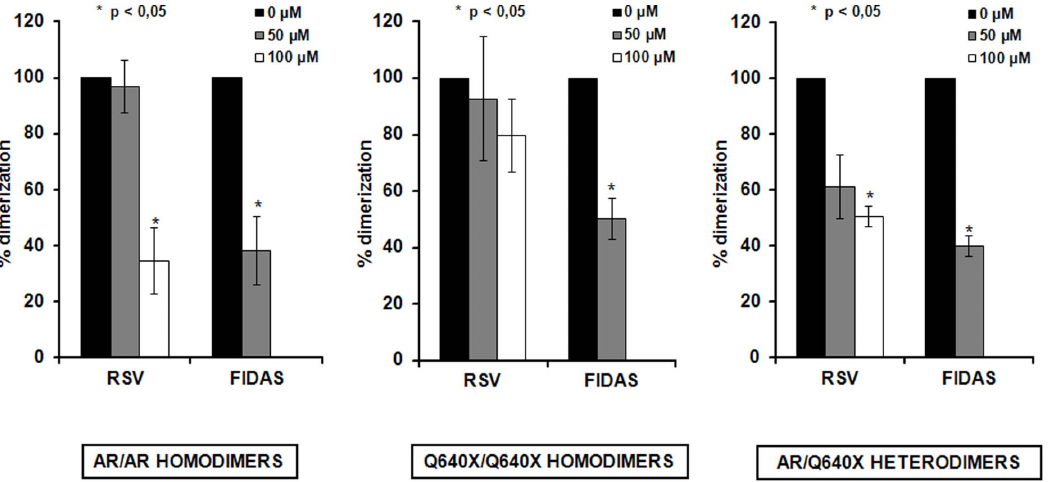
Figure 5. Effects of RSV and FIDAS on the dimerization of AR and Q640X. Formation of AR and Q640X homo/hetero-dimers was analyzed 24 hours after RSV or FIDAS treatment using a M2H as described in Material and Methods. Within this time frame RSV as well as FIDAS did not